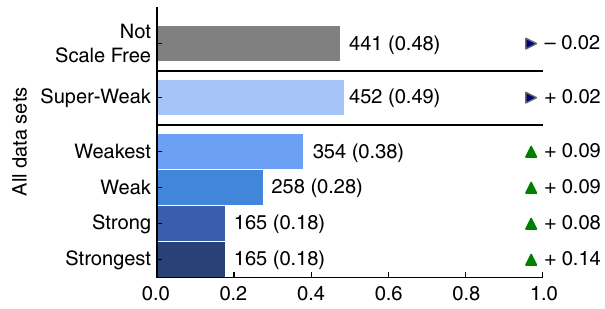
Fig. 6 Proportions of networks in each scale-free evidence category